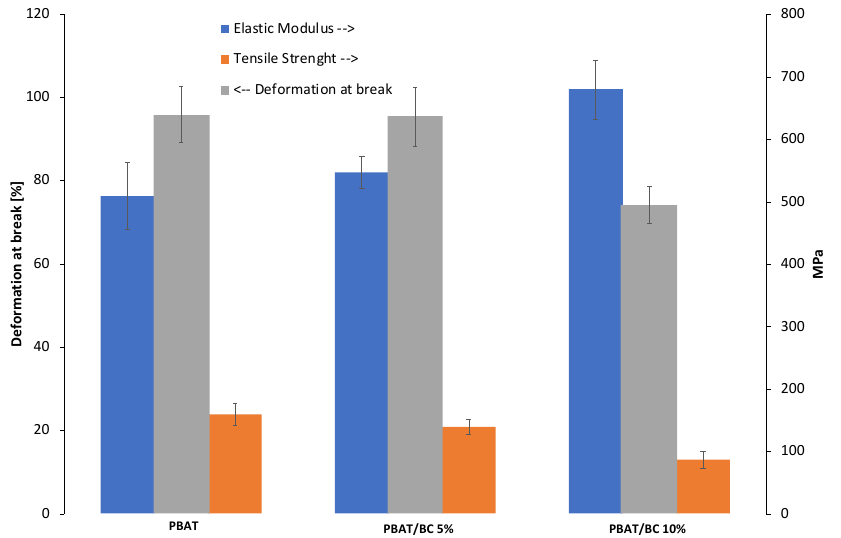
Figure 10. Histogram of the elastic modulus, tensile strength, and deformation at break of PBAT- based blown film.